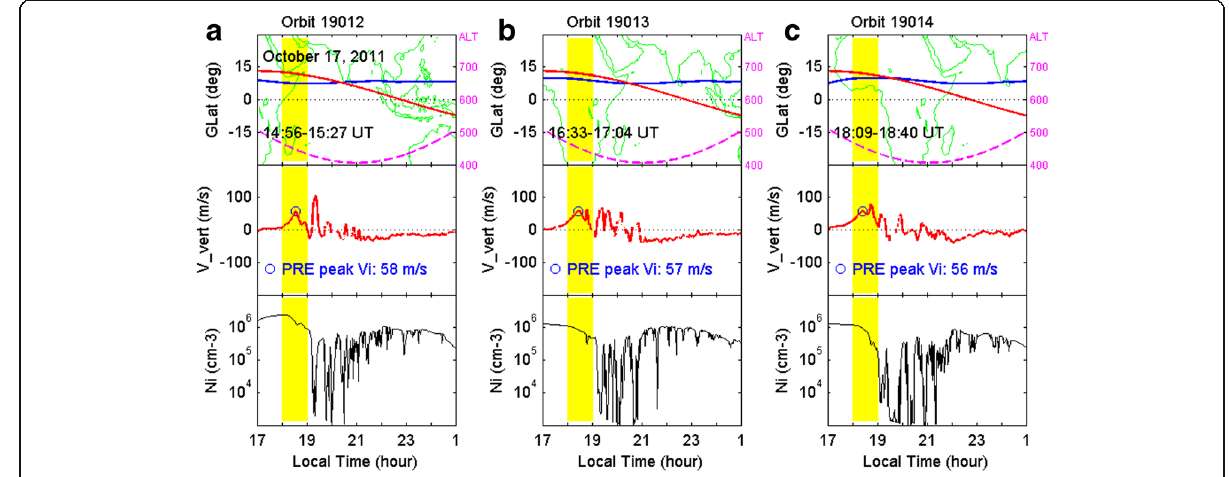
Fig. 6 Examples of plasma bubbles with large prereversal enhancement (PRE) detected by the C/NOFS satellite during three successive orbits ( a , b , c ) on 17 October 2011. From top to bottom are the C/NOFS orbit, the vertical ion drift velocity, and the ion density, respectively. (After Huang and Hairston